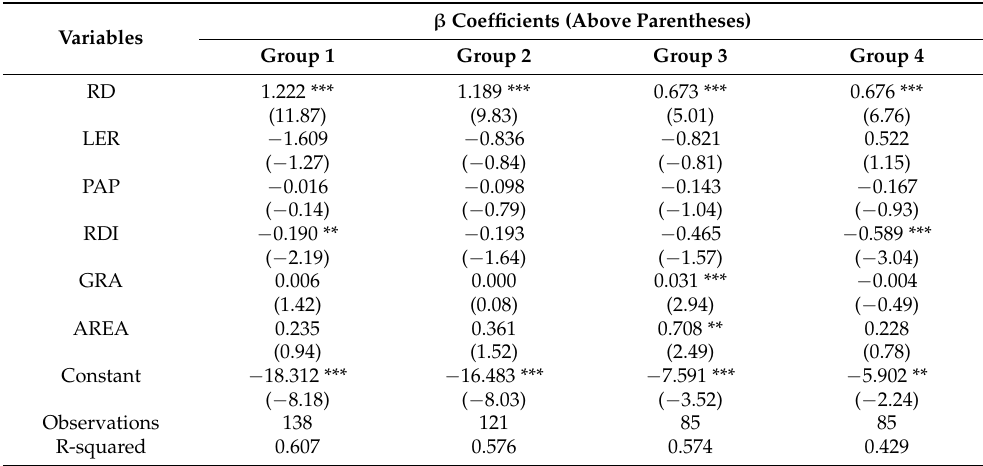
Table 5. Regression results of sub-groups for different regulations (Model 2).